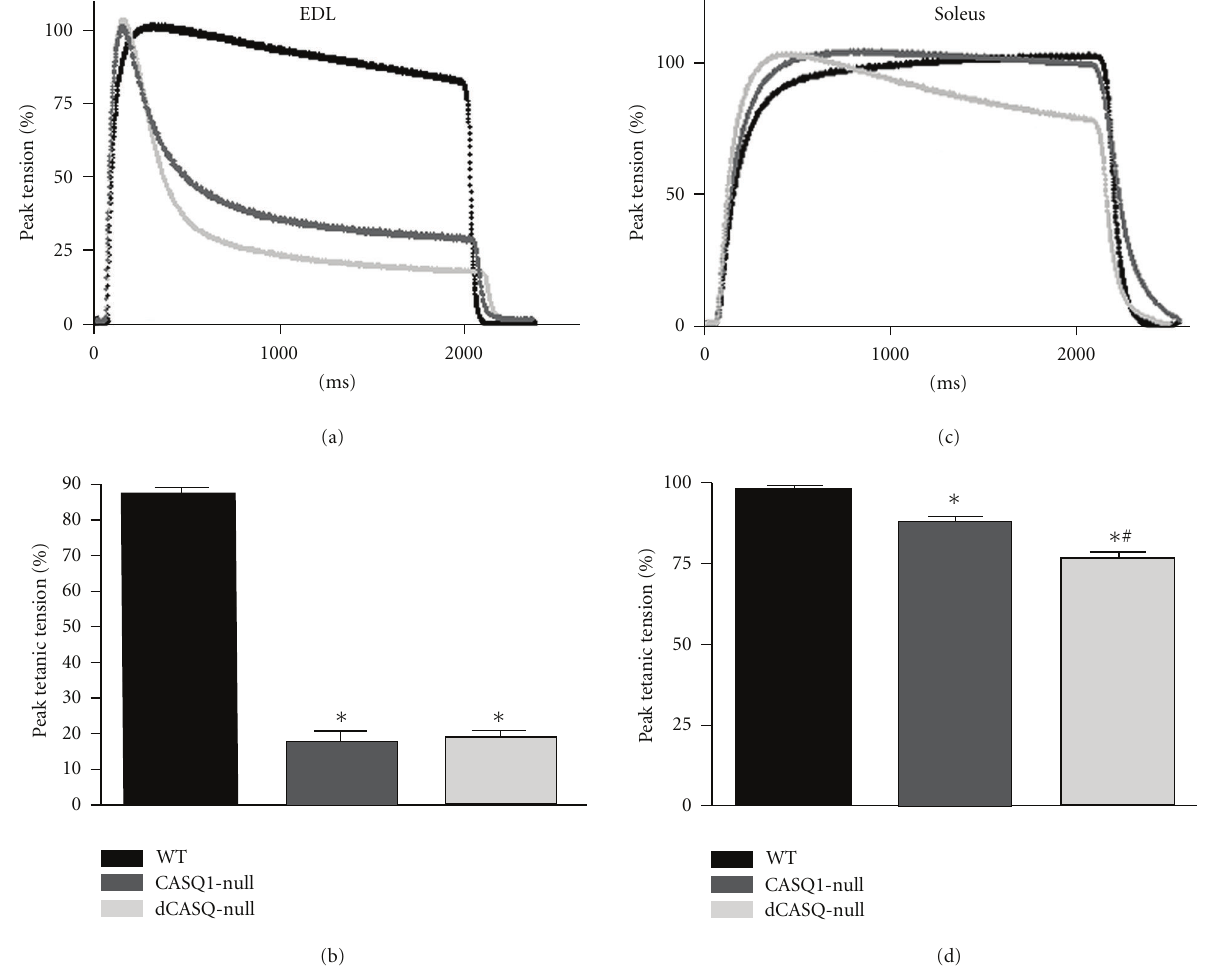
Figure 6: Tension decline and residual tension after 2seconds of high-frequency stimulation in EDL and Soleus of CASQ1-null and dCASQ- null mice. (a) and (b) When stimulated at high frequency (2s, 140Hz) EDL muscles of both CASQ1-null and dCASQ-null displayed a strong drop in tension (by about 80%) compared to WT. (c) and (d) Conversely, in Soleus muscle (stimulated at 90 Hz for 2s) this e ff ect was considerably less: compared to WT, tension was decreased by ∼ 15% in CASQ1-null and 25% in dCASQ-null (EDL: WT n = 8, CASQ1-null n = 10, dCASQ null n = 9, Soleus: WT n = 8, CASQ1-null n = 10, dCASQ null n = 10). ∗ Significantly di ff erent from WT; #significantly di ff erent from